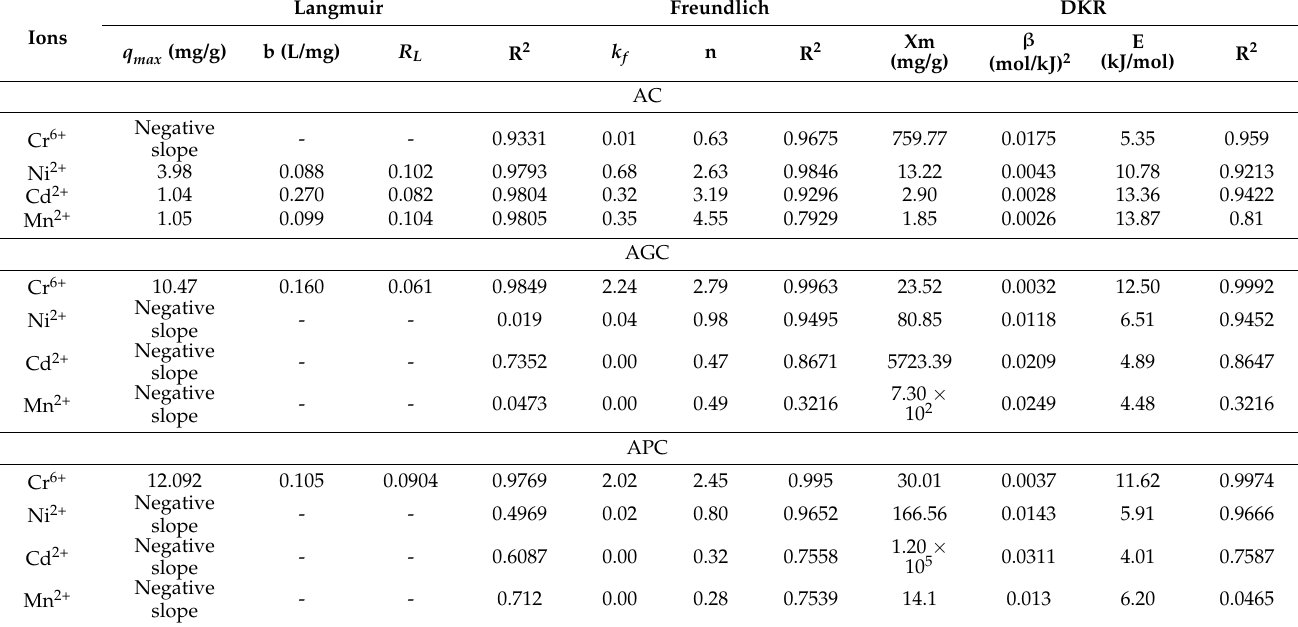
Table 3. Langmuir, Freundlich, and DKR isotherm parameters for the adsorption of tested heavy